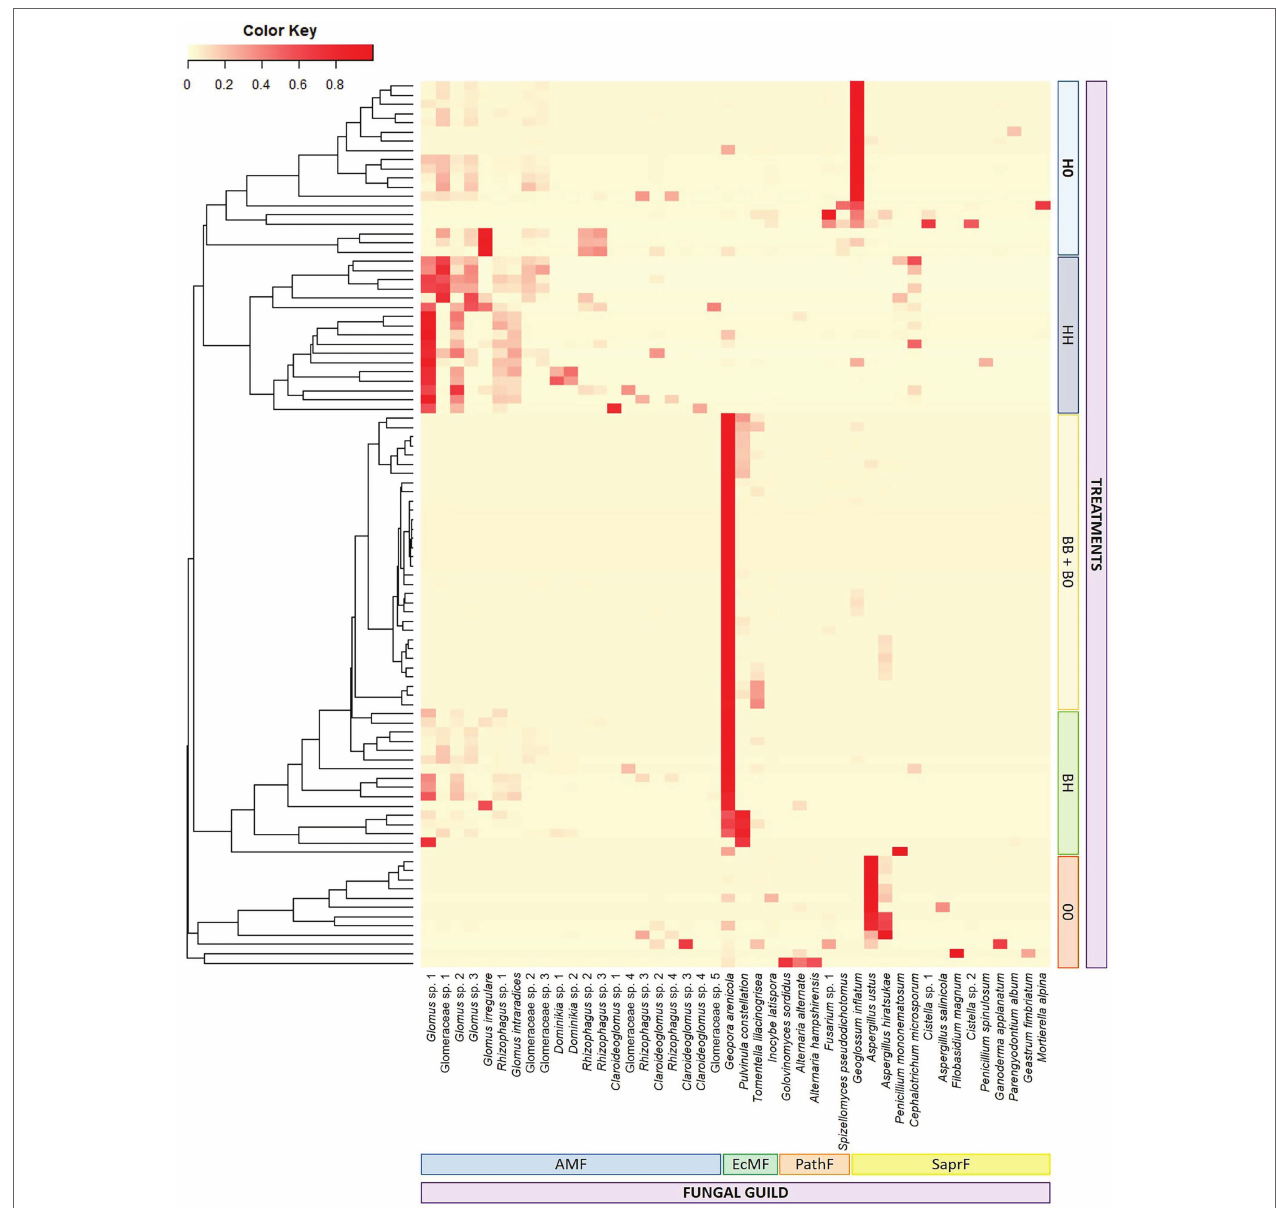
FIGURE 4 | Heatmap displaying composition of fungal communities in middle compartments of the experimental treatments. Due to visualization limitations, operational taxonomic units with less than 10% as their maximum relative abundance were not considered . Fungal guilds: AMF = arbuscular mycorrhizal fungi, EcMF = ectomycorrhizal fungi, PathF = pathogenic fungi, SaprF = saprotrophic fungi ( n = 16). Treatments: 00 = without plants in lateral compartments, B0 = B. pendula in only one lateral compartment, BB = B. pendula in both lateral compartments, BH = B. pendula and H. caespitosum in lateral compartments (interaction treatment), H0 = H. caespitosum in only one lateral compartment, HH = H. caespitosum in both lateral